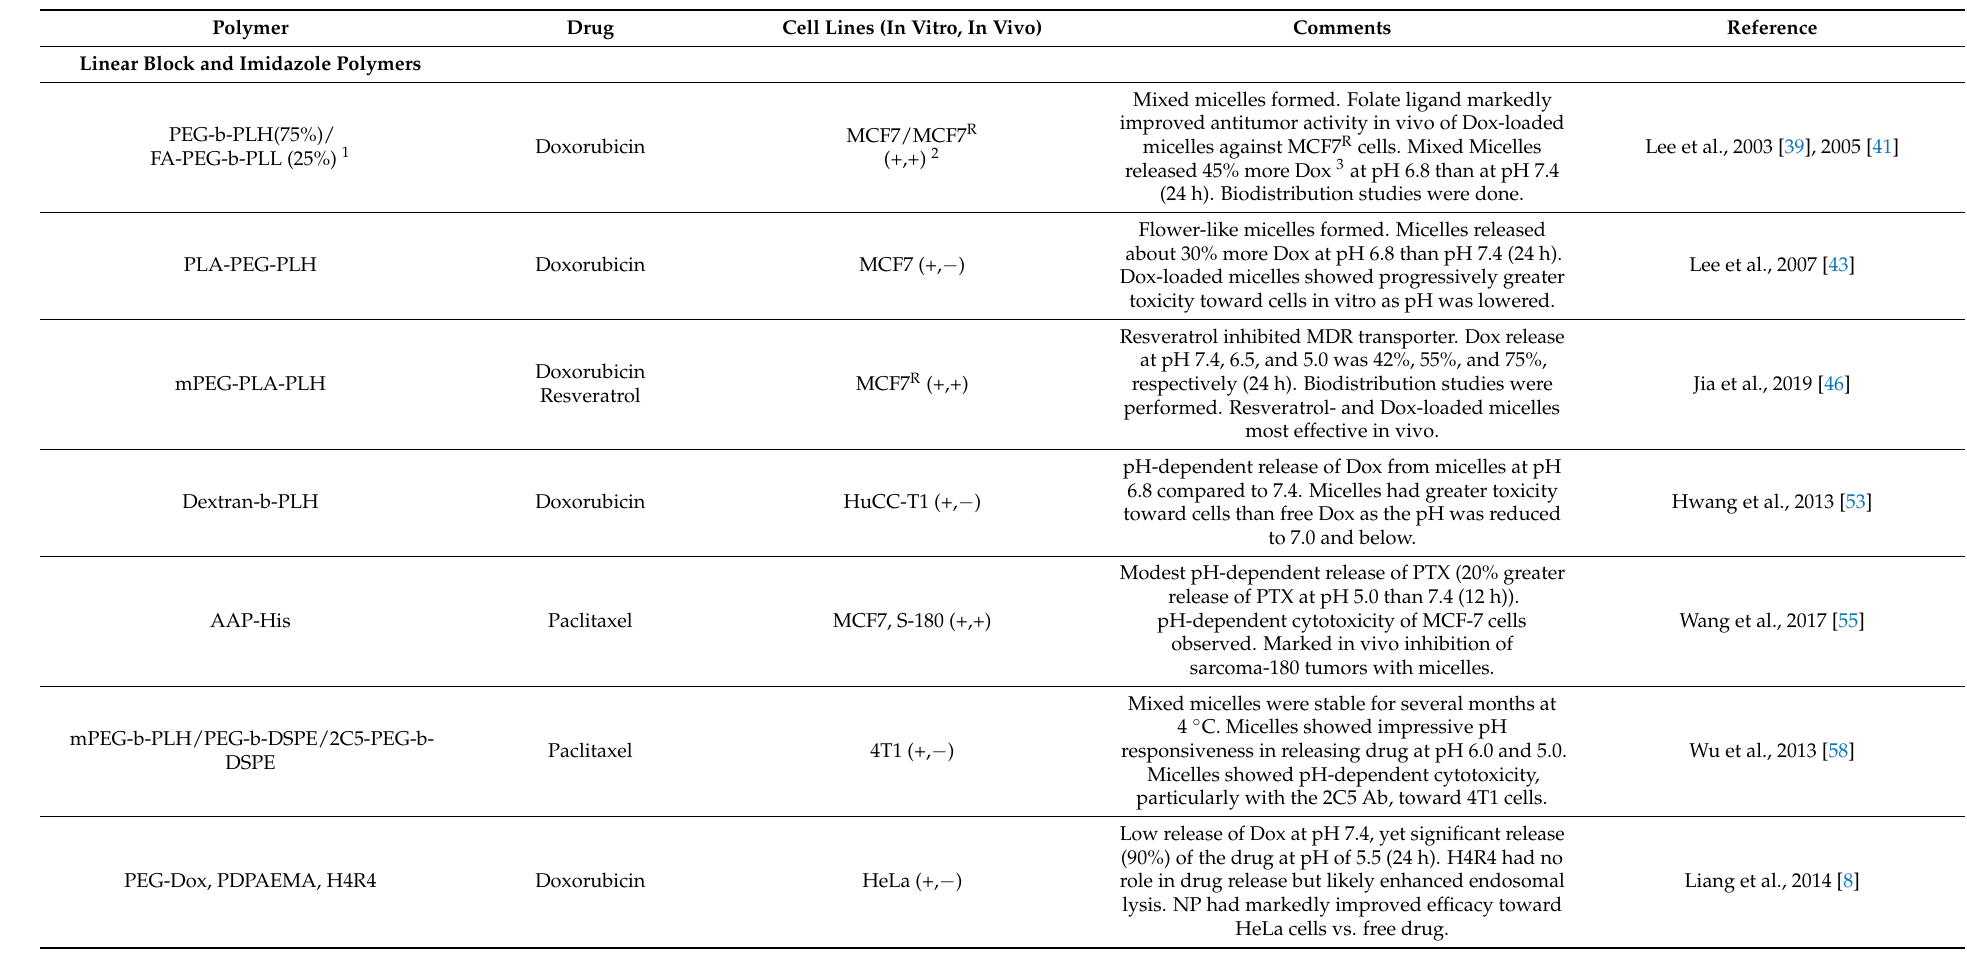
Table 1. Selected pH-sensitive and drug-loaded